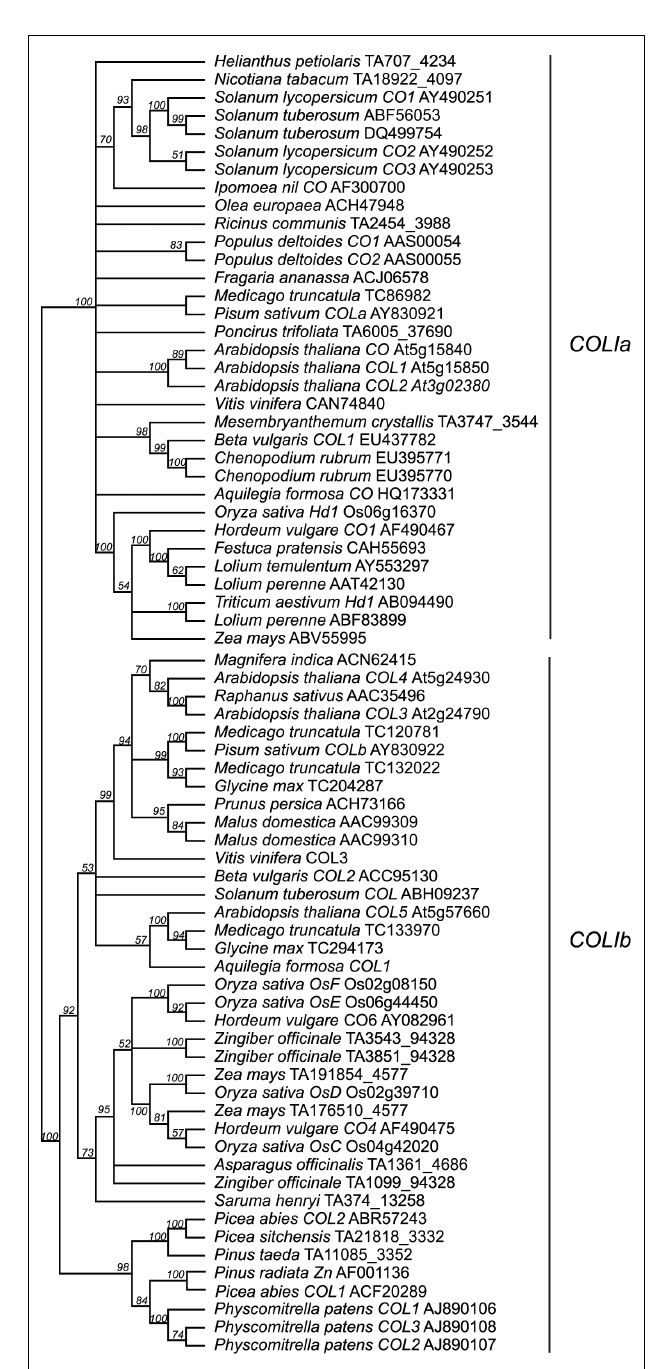
FIGUREA2 |Type I CO -like gene tree. Expansion of the tree presented in Figure 4 .